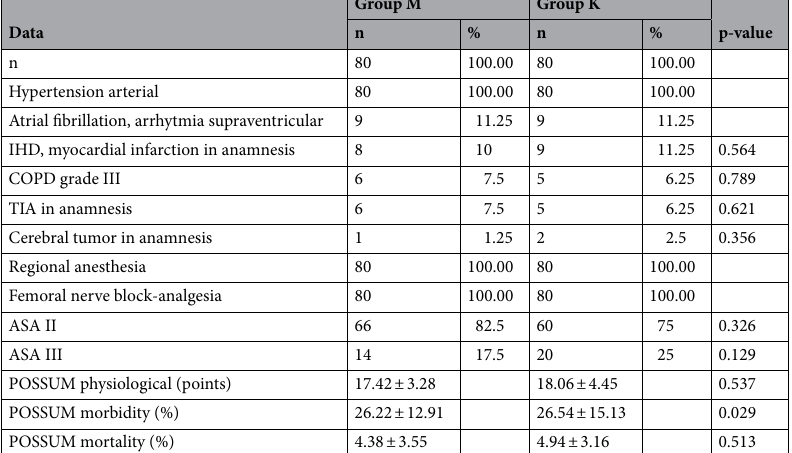
Table 2. Distribution of comorbidities and anesthesia in the analyzed patients aged above 65 years old divided into the study group (M) and the controls (K). IHD ischaemic heart disease, COPD chronic obstructive pulmonary disease, TIA transient ischaemic attack, ASA American Society of Anesthesiology Score, POSSUM physiological and operative severity score for the enumeration of morbidity and mortality.